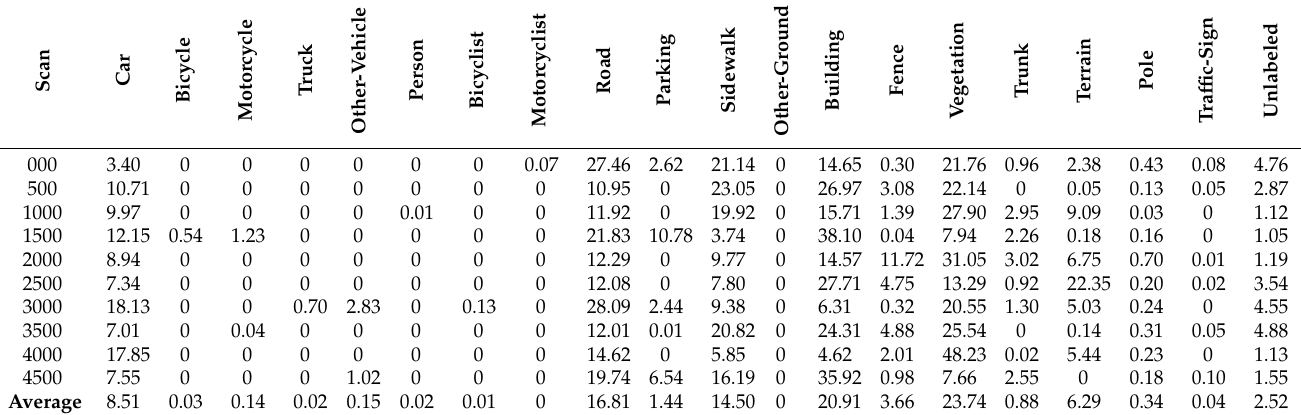
Table 1. Statistics on the proportion of various environmental elements in each